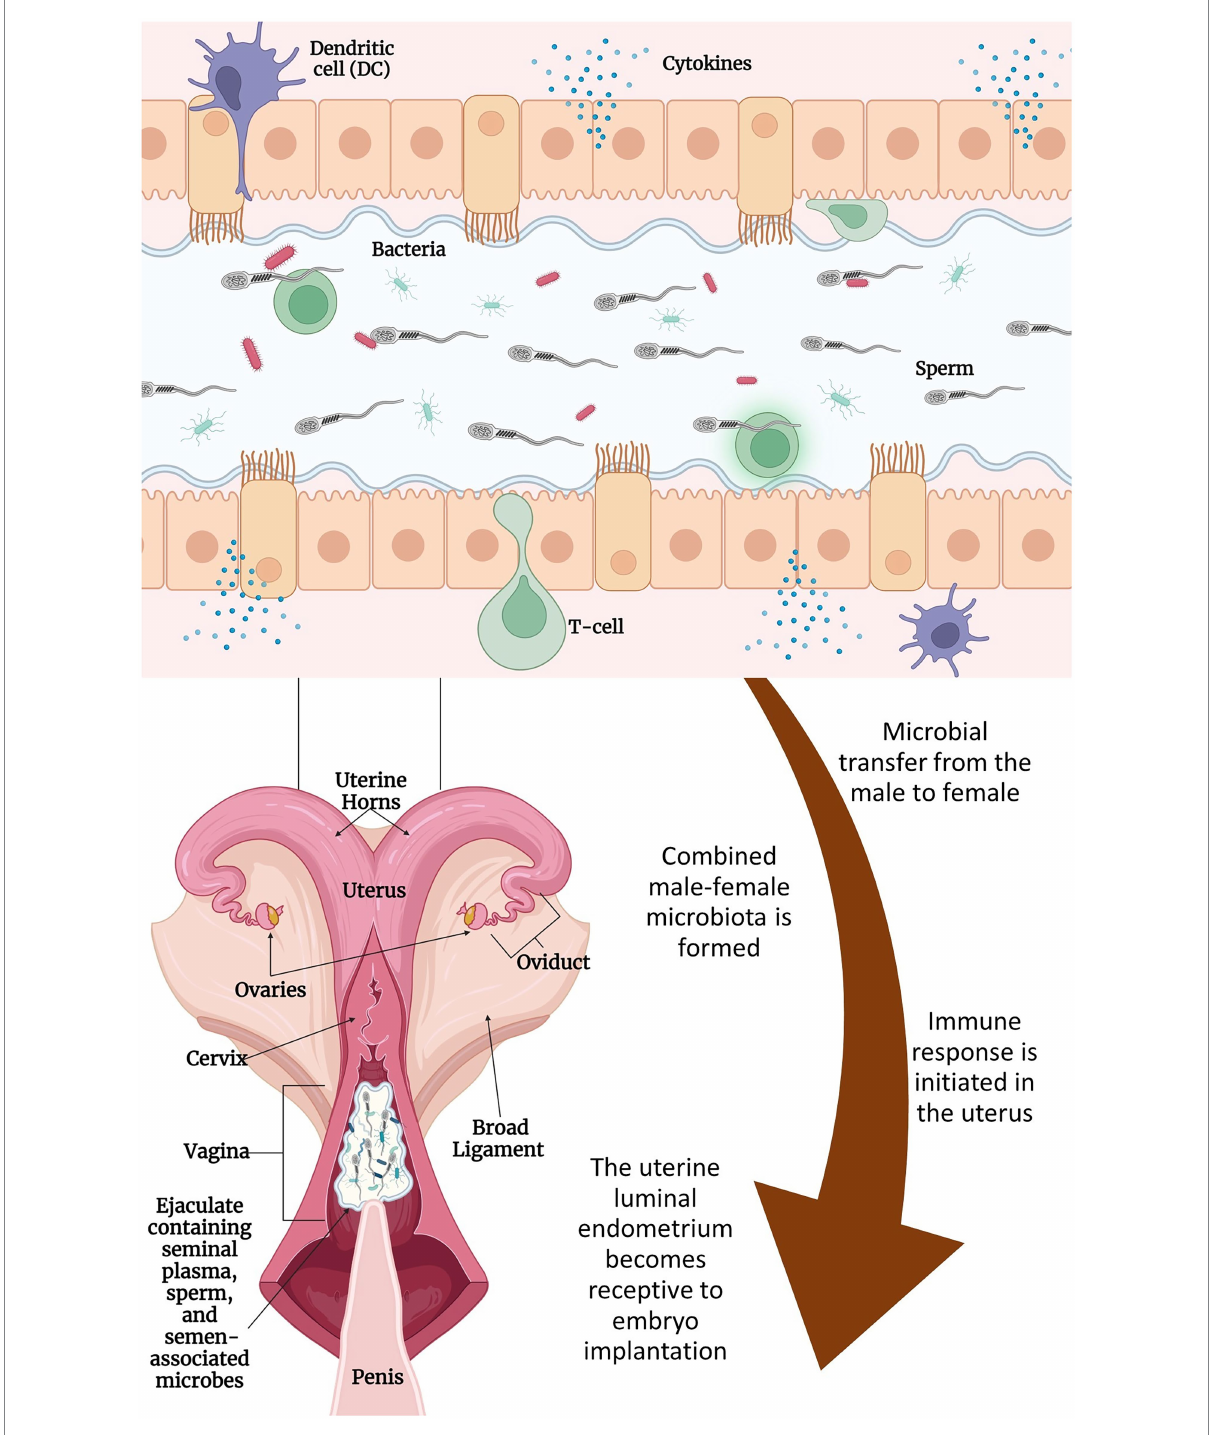
FIGURE 1 Proposed interactions between seminal and uterine microbiome and their effects on fertilization and implantation: semen is deposited in the cranial vagina of the cow/heifer by the bull. Microbes associated with seminal plasma and sperm mix with microbes associated with the female reproductive tract and migrate through the cervix and into the uterine lumen with the help of contractions from the female’s vaginal and cervical muscularis and the movement of sperm. During this time, the male–female microbes and their metabolites contribute to the immune reaction that takes place in the endometrium of the uterus. Immune cells (e.g., dendritic cells and macrophages) will respond and modulate vascular changes including inflammation of the uterine endometrium. These changes along with other specific responses will lead to the outcome of embryo implantation and contribute to post-conception fetal development. Figure created with